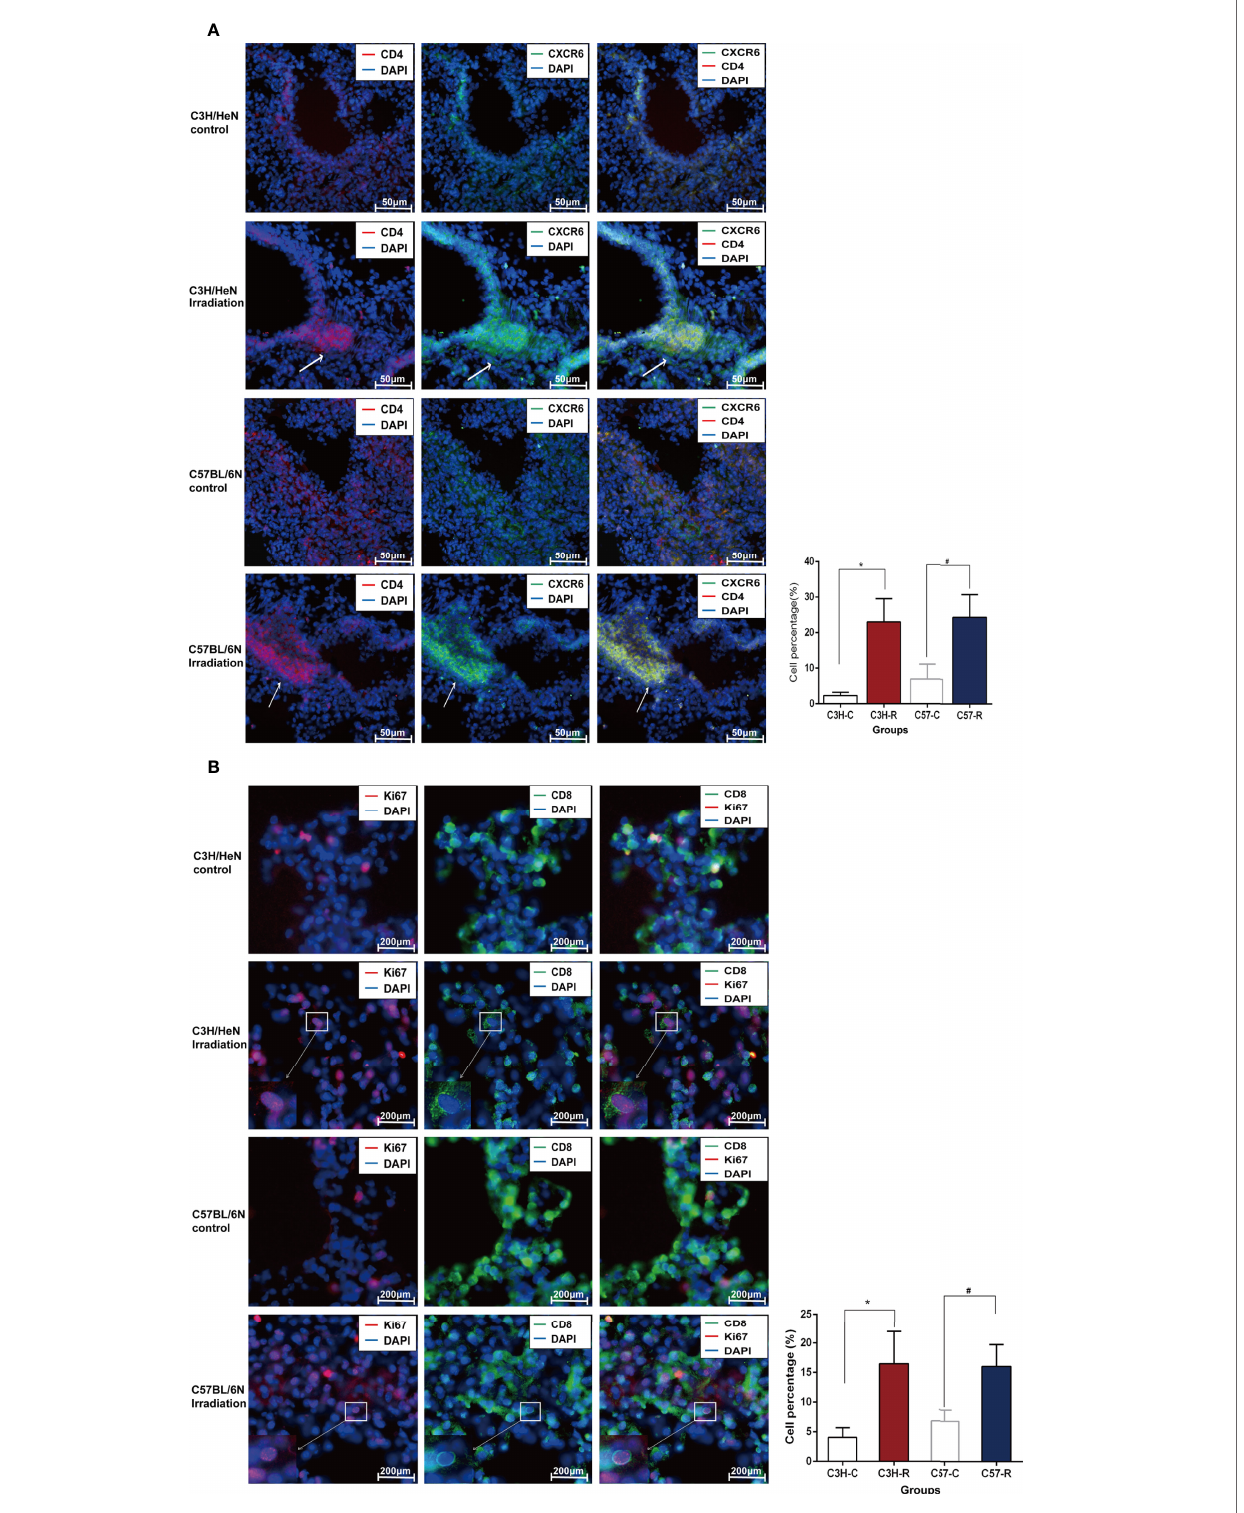
FIGURE 5 | Immuno fl uorescence data con fi rmed the existence of the subset of T cells after radiation. (A) Immuno fl uorescence staining diagrams of genes Cd4 and Cxcr6 in lung tissue before and after radiation. (B) Immuno fl uorescence staining diagrams of genes Cd8 and Mki67 in lung tissue before and after